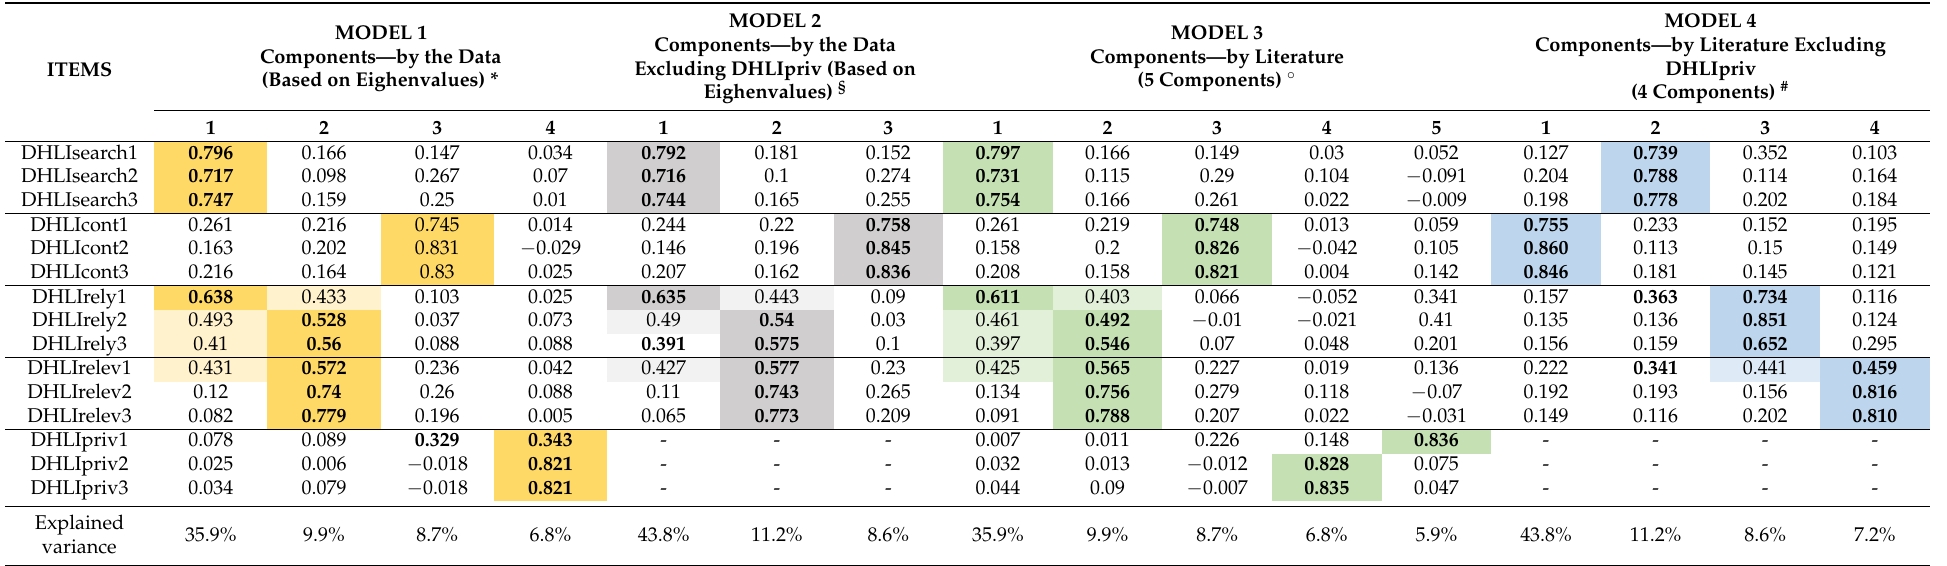
Table 4. Principal component analysis (varimax